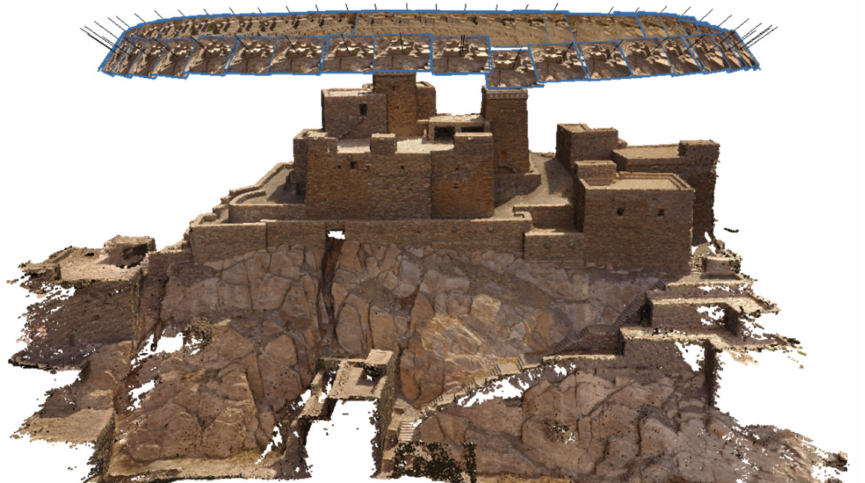
Figure 10. UAV-SFM 3D point cloud (oblique images block).